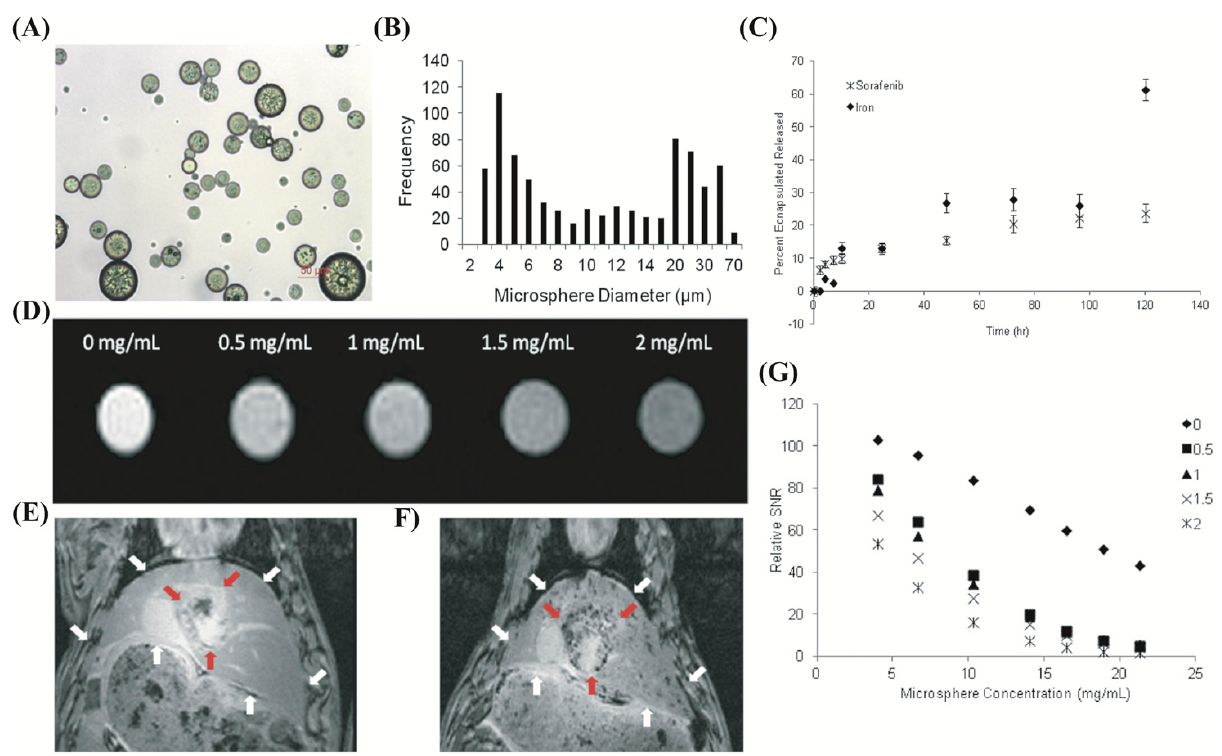
Figure 6. ( A ) Confocal microscopic image of PLG microspheres with sorafenib and iron oxide (scale bar represents 50 μ m). ( B ) Histogram of microsphere sizes (average size diameter was 13 μ m). ( C ) Release kinetics of sorafenib and iron oxide from the microspheres. ( D ) MRI image (T 2* weighted) of PLG sorafenib iron oxide agar phantoms. The decay rates increased (signal dephasing effects of iron oxide) with increasing microsphere concentration. ( E ) Preprocedural MRI image (T 2* weighted) of the liver (white arrows) and tumor position (red arrows). ( F ) Postprocedural MRI image (T 2* weighted) of the liver demonstrates intense signal loss at the tumor due to the catheter-directed PLG microspheres delivery. ( G ) Signal decay rates with respect to increased microsphere concentration. Reproduced with permission from Ref. [146].